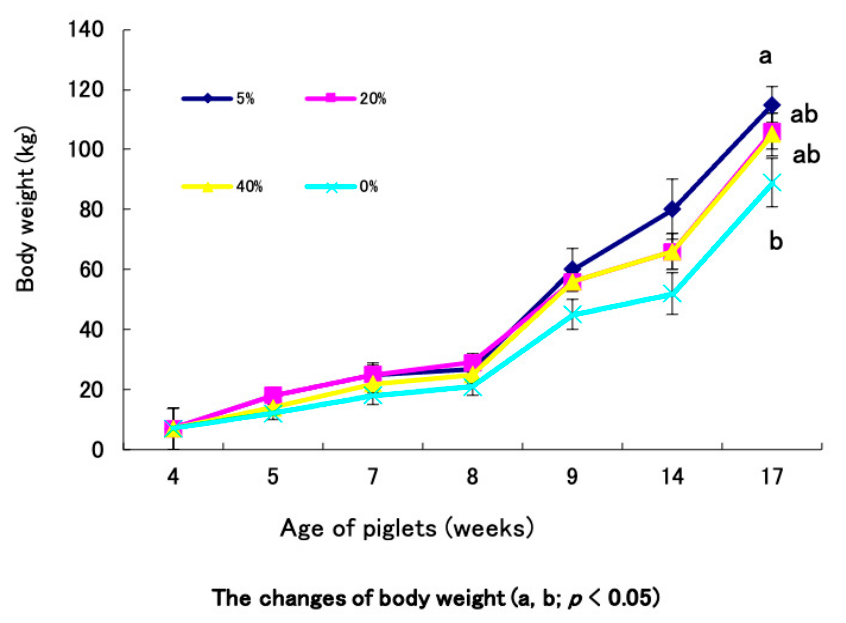
Figure 3. Body weight gain of study pigs over the feeding trial. The results presented are the mean ± SD of three independent experiments. Different letters among contrasting group indicate significant (a, b; p < 0.05) difference while same letter indicates no significance difference.